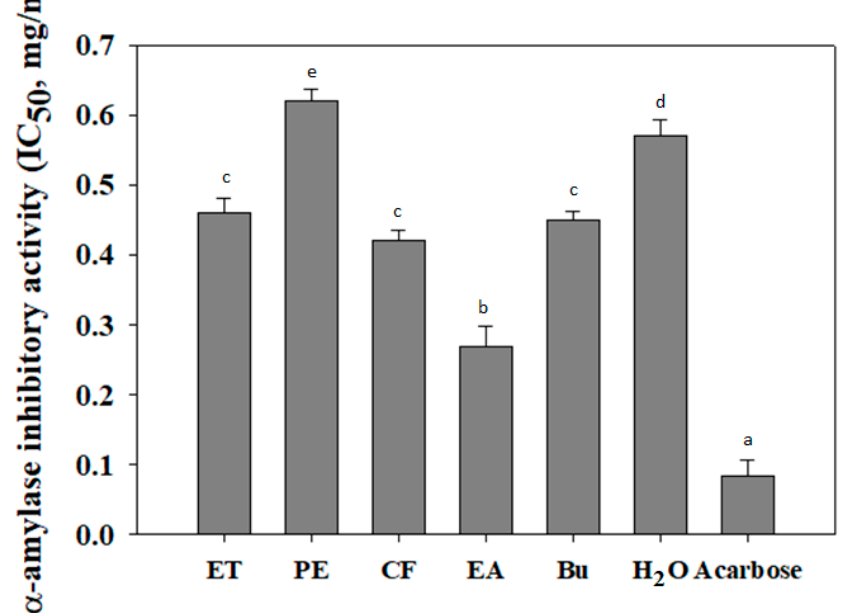
Figure 3. The inhibitory effect of wild bitter melon extract and fractions on α -amylase activity. IC 50 is the half maximal inhibitory concentration of extract or fractions on α -amylase activity. Acarbose was used as the positive control. Each determination was made in three independent experiments, and the data were shown as means ± SD. Different letters a–e indicate significant differences among groups ( p < 0.05). Ethanol extract (ET), petroleum ether (PE), chloroform (CF), ethyl acetate (EA), n-butanol (Bu), and H 2 O fraction.